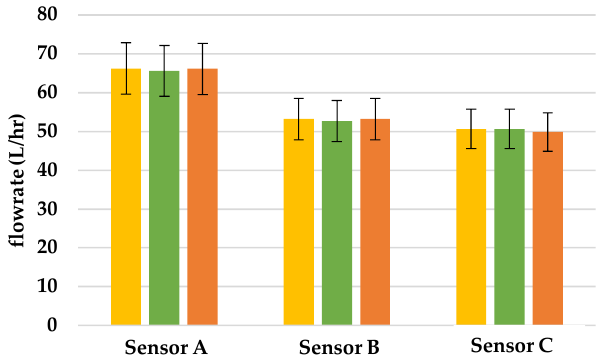
Figure 9. Flowrate of sensors when there is 1.98 cm 2 leakage in the pipeline.